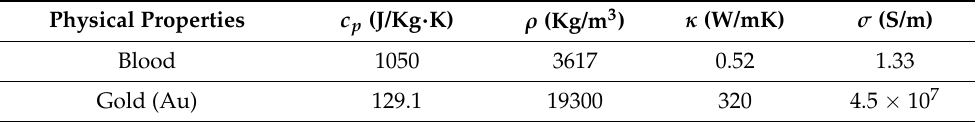
Table 1. Thermo-physical properties of blood and Gold